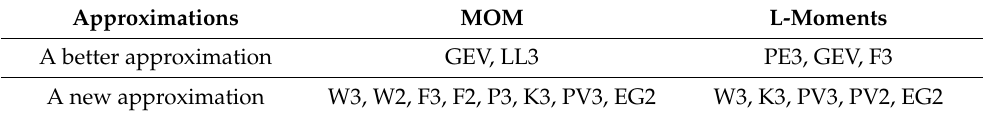
Table 1. Novelty